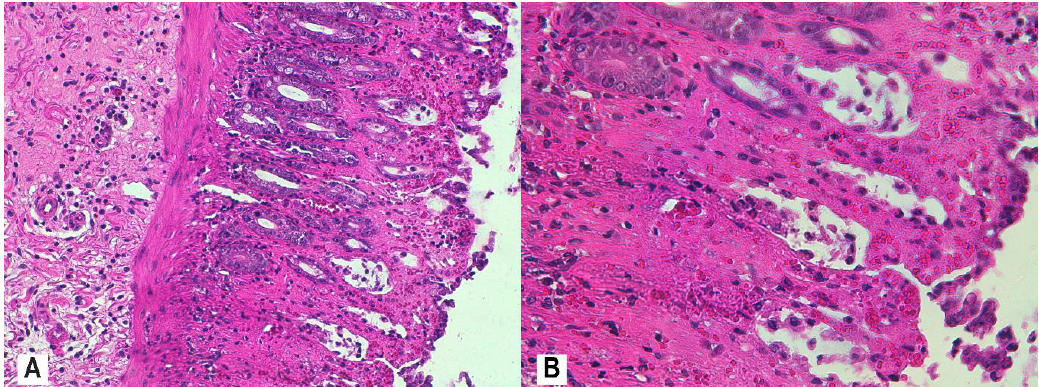
Figure 8. Colon histology of rats administered MM (AA + MM group). Colon tissue of rats that were administered MM for 11 consecutive days prior to AA exposure was collected 24 h after AA exposure and demonstrated moderate inflammatory infiltrate in the mucosa and submucosa, few neutrophils in the lamina propria, neutrophil infiltration of crypt epithelium in <50% of crypts, and recovering luminal epithelium; H&E stain, 20× ( A ), 40× ( B ). Abbreviations: AA, acetic acid; H&E, hematoxylin and eosin; MM, MegaMucosa™.